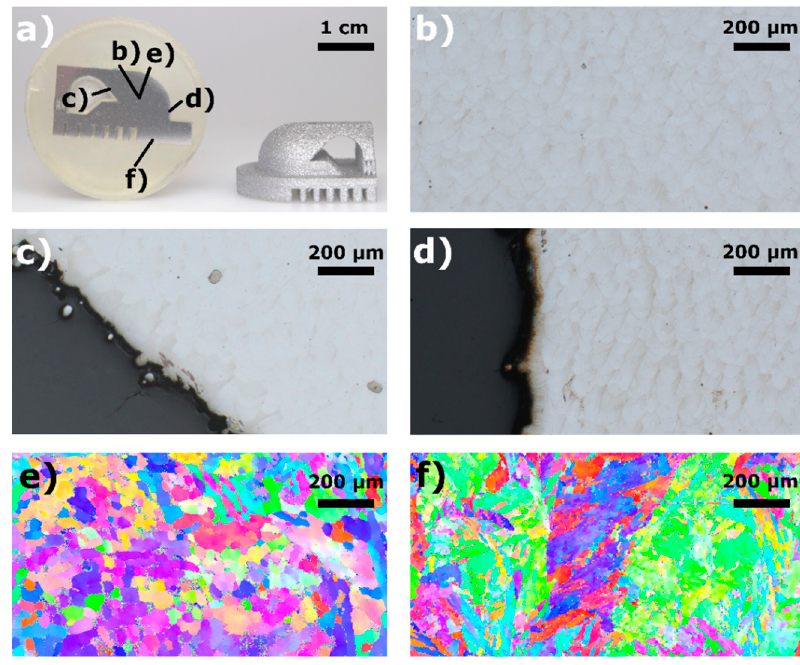
Figure 10. ( a ) Benchmark in its raw form and as a metallographic specimen. ( b ) Microstructure resulting from the volumetric parameters developed in step 4, serving as a reference. ( c ) Microstructure resulting from downskin exposure parameters. ( d ) Areas resulting from contour exposure. ( e , f ) Electron backscatter diffraction (EBSD) can be used to evaluate microstructural changes due to changing exposure parameters in near surface areas.